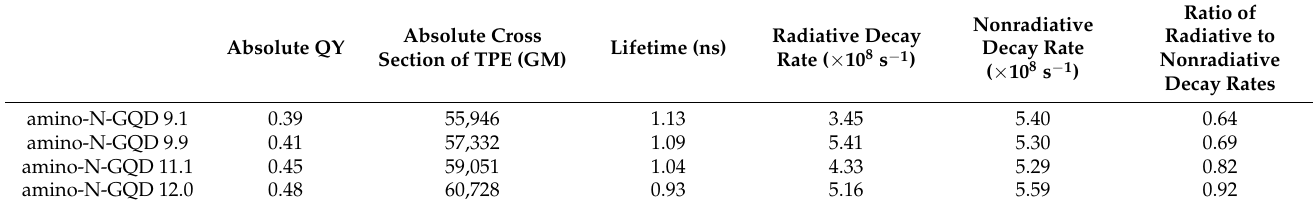
Table 2. Two-photon properties of the sorted amino-N-GQDs. Delivered dose: 0.75 µ g mL − 1